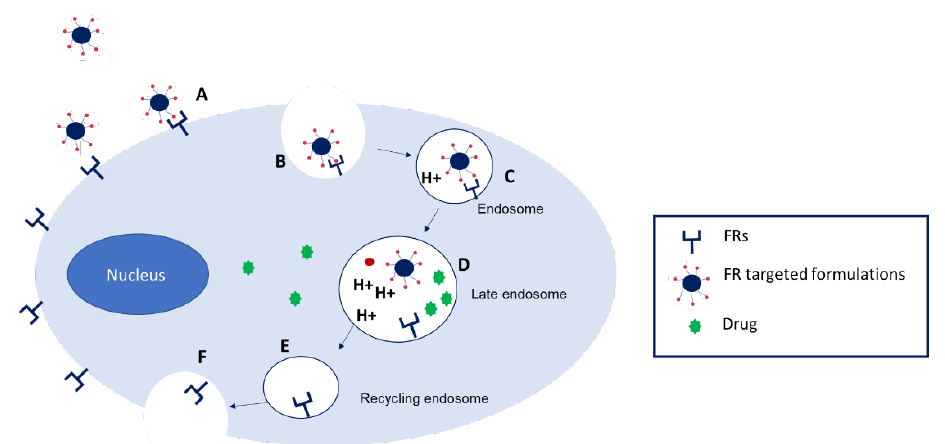
Figure 3. Scheme showing folic acid- and FR-targeted formulations internalization. Folic acid or another ligand binds to folate receptor ( A ). An invagination of the plasma membrane is generated ( B ) and the folate receptor-ligand conjugate is enclosed in a vesicle named endosome ( C ), where the acidic pH triggers conformational changes in the folate receptors, inducing the release of the ligand ( D ) and the drug into the cells, and the recycling of the folate receptor to the cell surface ( E , F ). In human, four isoforms of FRs have been identified: FRα, FRβ, FRγ, and FRδ. FRα, FRβ and FRδ are glycosyl-phosphatidylinositol-anchored membrane proteins. However,